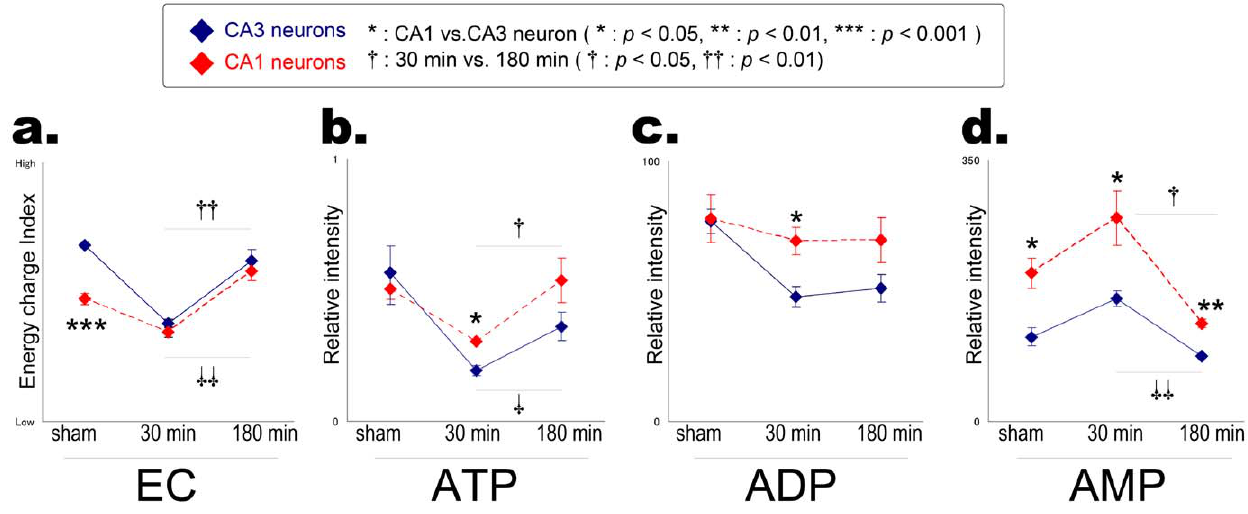
Figure 3. Recovery of energy consumption in CA1 and CA3 cells. The MALDI-imaging results of mouse hippocampus of control and kainate- administered mice at 30 and 180 minutes after administration. The signals of adenosine nucleotides as well as the calculated EC-index values on each pixel, were collected from CA1 and CA3 cell-layer regions and averaged. Values are presented as means (S.E.M.) Control (sham-operated, n=3), 30 min (n=4), and 180 min (n=4).